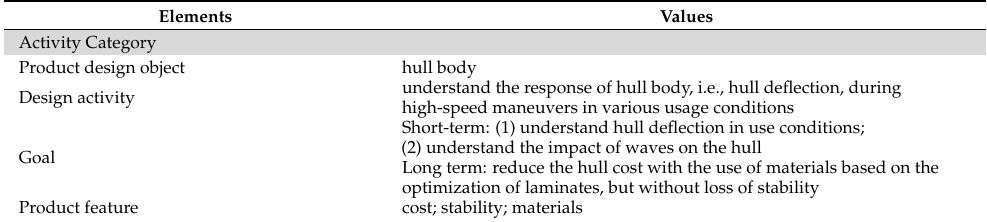
Table 4. Boat scenario: summary of the elements in the activity category and personnel category.